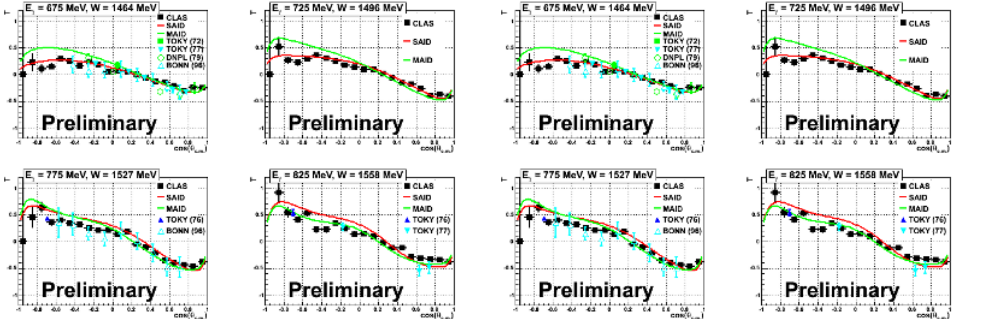
Fig. 1. Preliminary values of the T observable (black squares). Overlaid on these plots are the current SAID [10] (red), MAID2007 [7] (green) These data have not been included in the fits. Data analysis by M. Dugger, ASU.